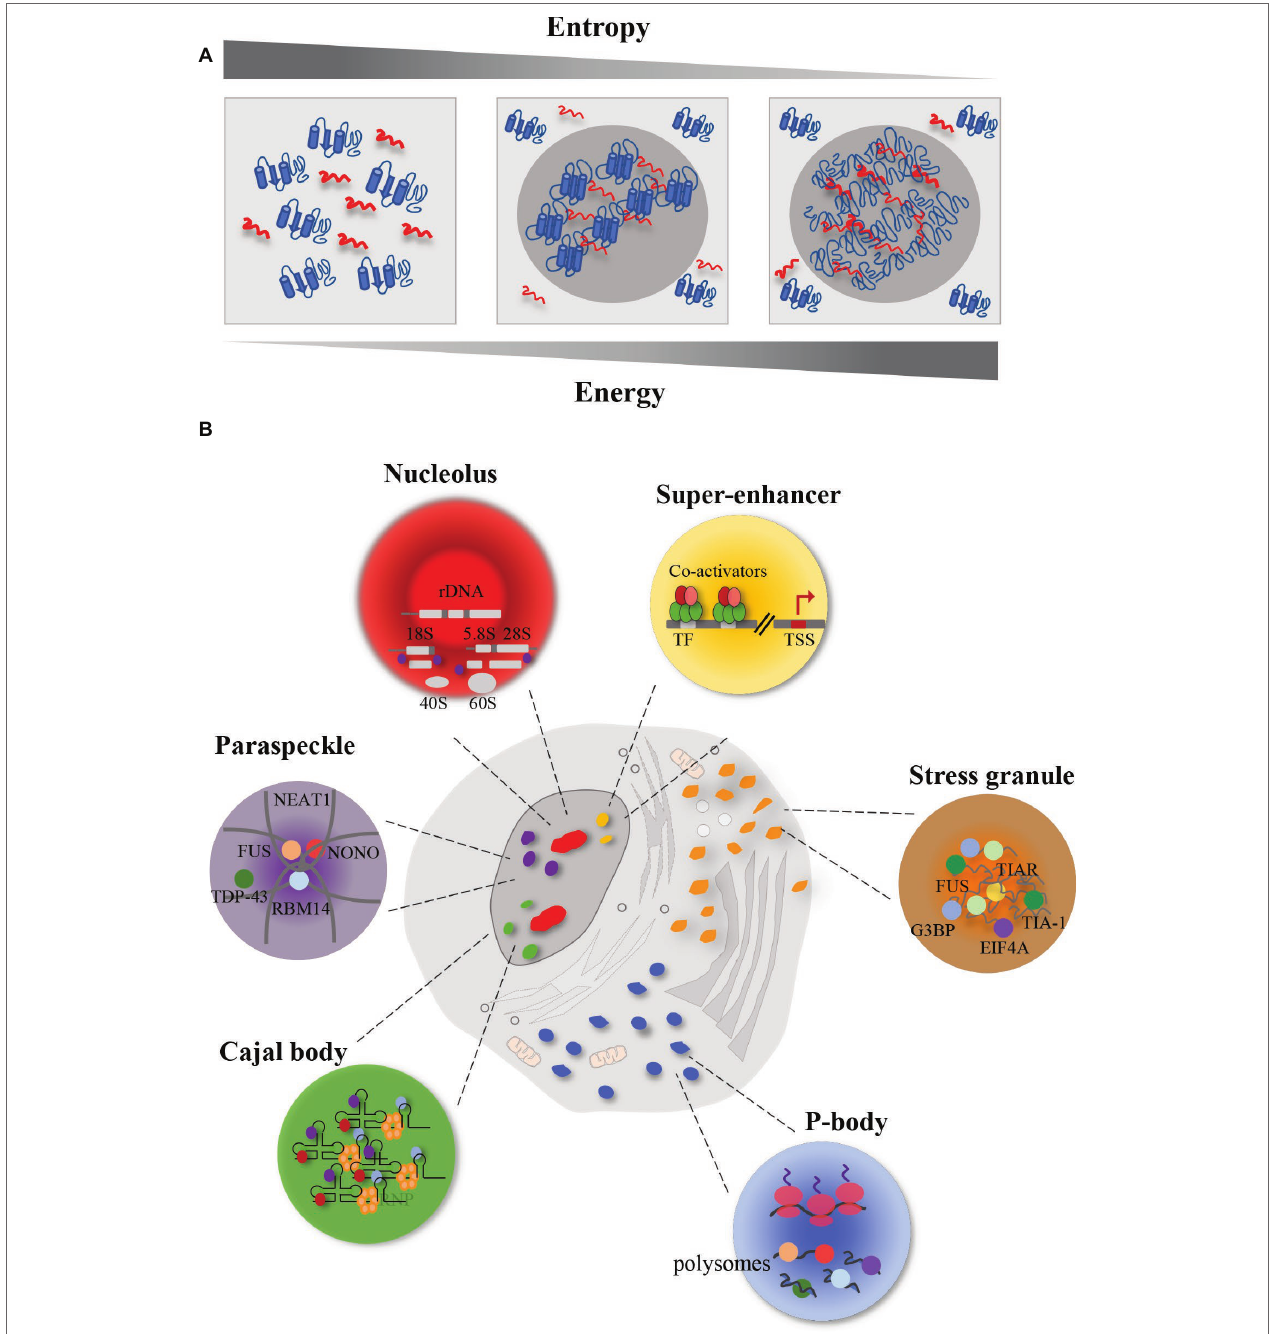
FIGURE 1 | Schematic representation of membrane-less organelles (MLOs). Eukaryotic cells contain different MLOs formed by liquid–liquid phase separation. (A) Representation of liquid–liquid phase separation. In order to promote interaction between macromolecules and to obtain a chemical equilibrium, high energy is required with a correspondent reduction of entropy. In this condition, proteins (in blue) and RNA (in red) are prone to undergo liquid–liquid phase separation. In particular, the increase in energy and the reduction in entropy lead to a decrease in macromolecule solubility and an increase in protein-RNA interactions. The result is a higher concentrated phase, that promotes the formation of membrane-less organelles (MLOs). (B) Representation of membrane-less organelles (MLOs). The MLOs form sub-compartments both in the nucleus and in the cytoplasm. Nucleus is characterized by the presence of nucleoli (in red) that are involved in the ribosome biogenesis; paraspeckles (in purple), whose formation is promoted by the lncRNA NEAT1 , that interacts with several RBPs, including FUS, in the core, and TDP-43 in the shell; Cajal bodies (in green) that are involved in the snRNP biogenesis; and super-enhancers (in yellow) that are clusters of master transcription factors and transcriptional co-activators involved in gene expression. In the cytoplasm, eukaryotic cells harbor P-bodies (in blue), involved in the control of mRNA translation and mRNA storage, and stress granules (in orange) whose formation, upon stress condition, requires the interaction between RNA (in grey) and